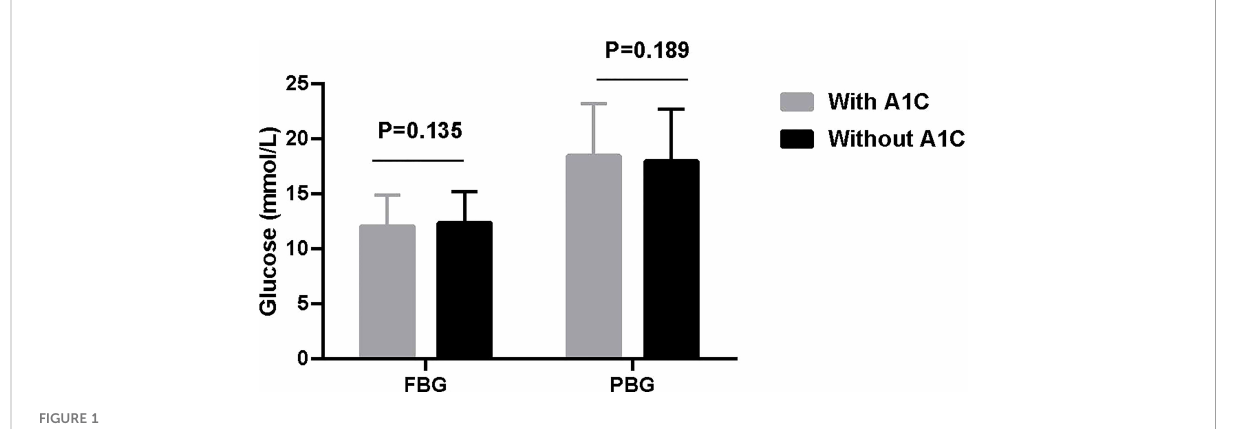
FIGURE 1 Patients ’ FBG and PBG levels at insulin